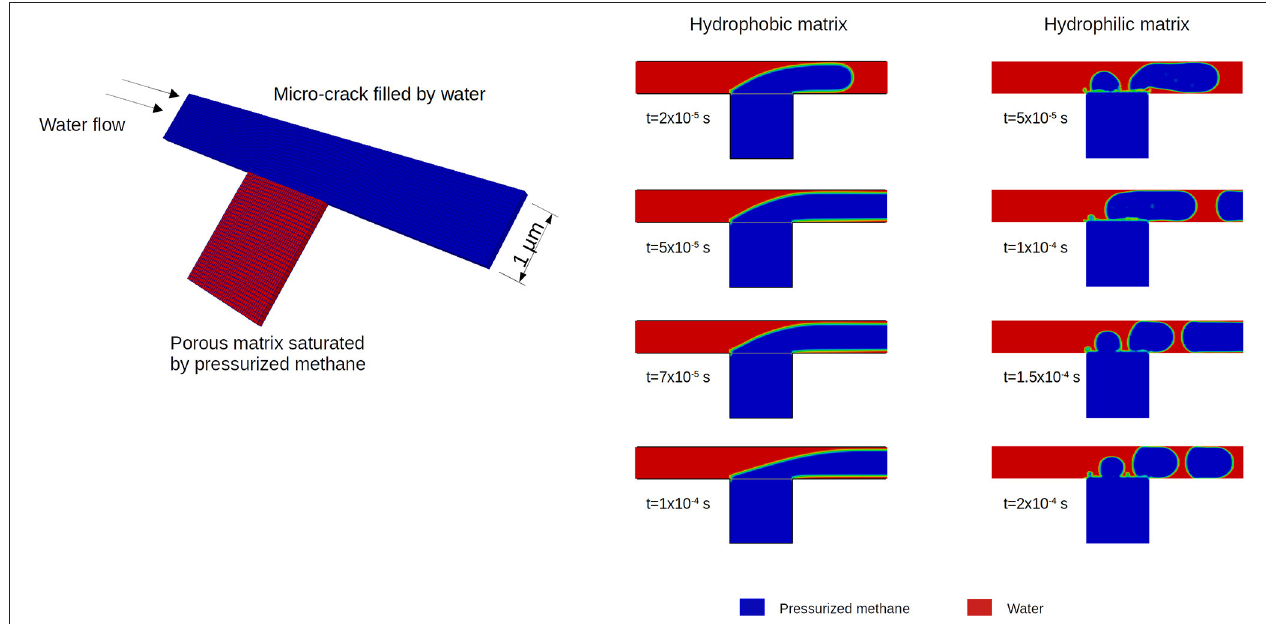
FIGURE 8 | Multi-scale simulations of the expulsion of methane stored in a microporous matrix into a soaked fracture. We investigated two scenarios: the fracture/matrix interface is non-wetting and the methane production is continuous, and the fracture/matrix interface is wetting and the gas is produced in a bubbly flow regime. The simulation setup is fully described in Soulaine et al.